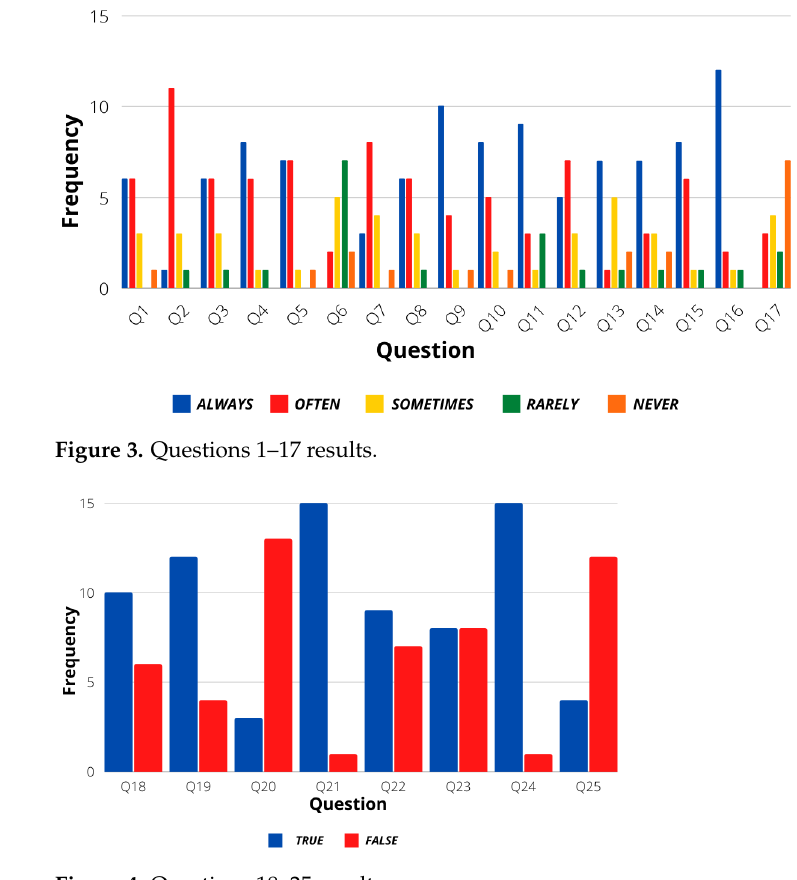
Figure 4. Questions 18–25